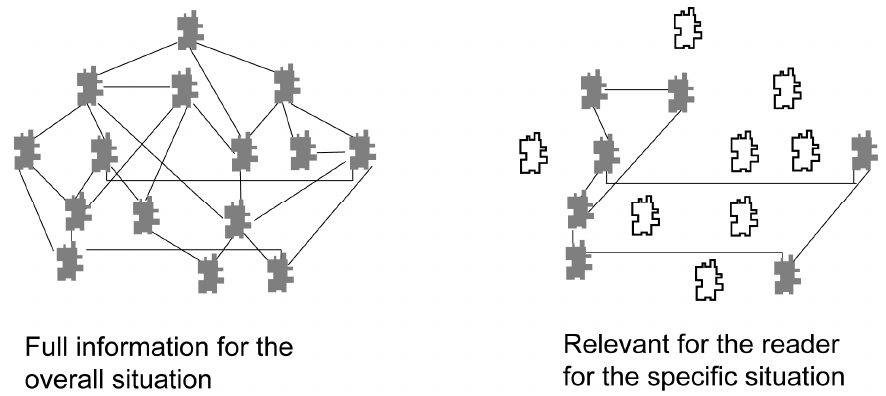
Figure 8. Information relevant to a situation. Each situation (or class of situations) only needs a subset of the information. High quality HII helps to keep the focus on only the relevant